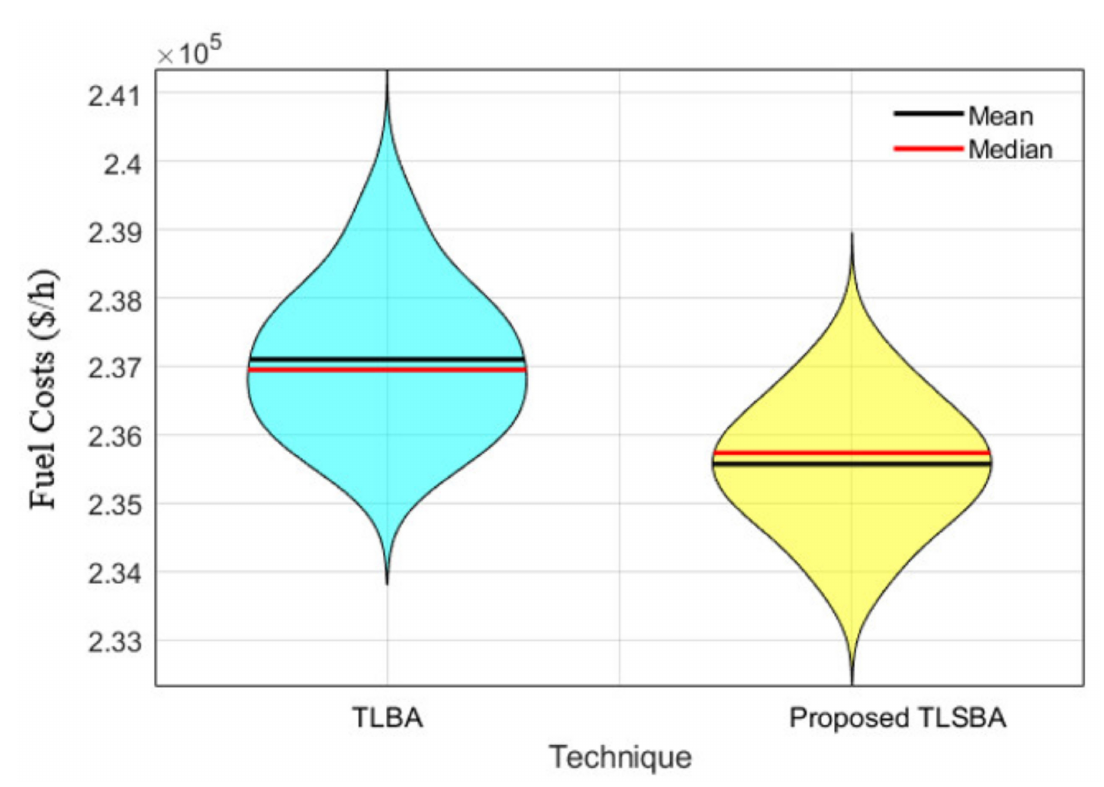
Figure 14. Violin plot obtained by TLBA and TLSBA for test system